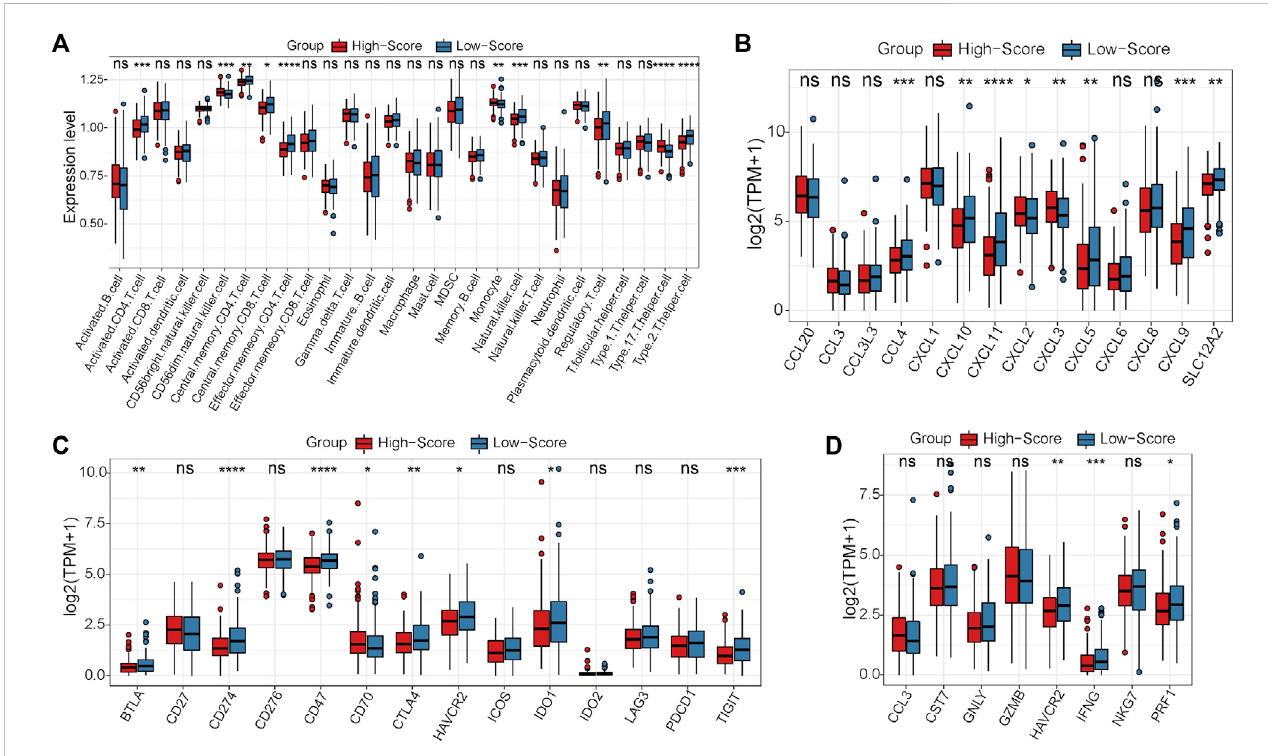
FIGURE 4 Differential analyses between the high- and low-score groups separated by the MSS-related risk score in the TCGA-CRC cohort. (A) The expression levels ofthe28immune cell types inthetwo groupswerevisualized byboxplot. (B – D) The expression status ofclassical chemokines (B) ,immunecheckpoint molecules (C) and cytotoxic molecules (D) between the two risk groups. * p < 0.05, ** p < 0.01, *** p < 0.001, **** p < 0.0001, ns, not signi fi